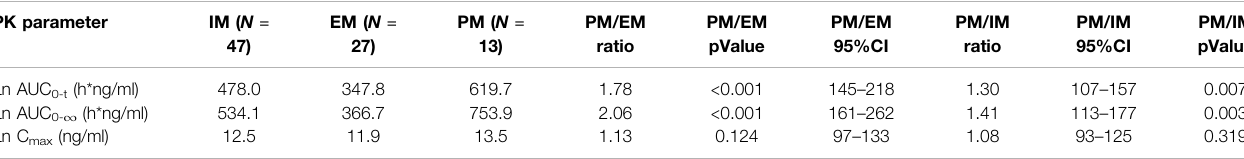
TABLE 3 | Comparison of pharmacokinetic parameters of different type of metabolizers. PK parameter